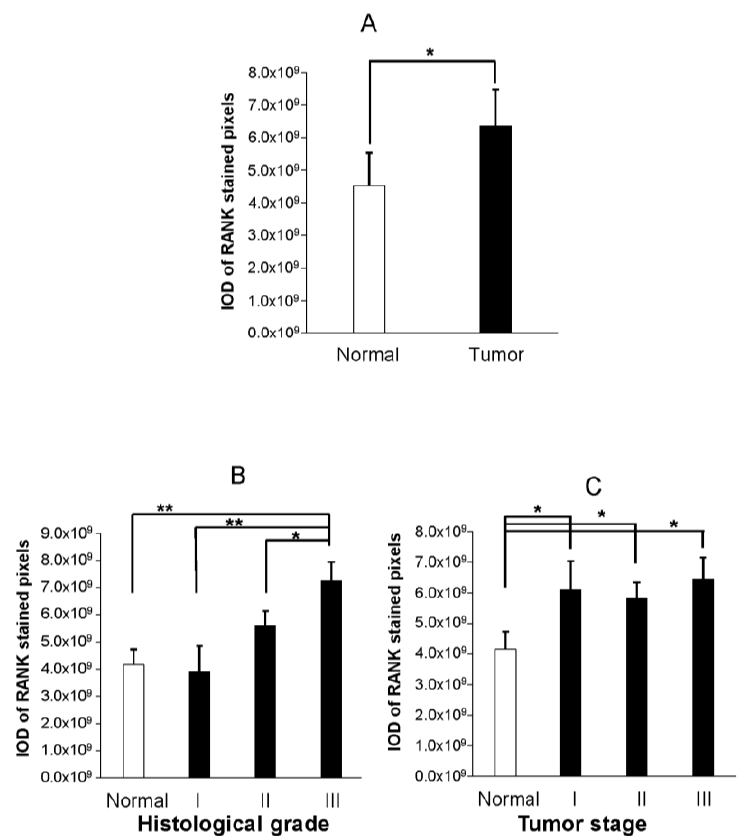
Figure 2. Graphs show mean ± SEM RANK protein expression as detected by quantitative immunohistochemistry in endometrium from normal and endometrial cancer samples. A Student’s t -test was employed for comparisons of RANK IHC staining between normal and tumor endometrial samples ( A ). An ANOVA followed by LSD post hoc analysis was performed to detect mean differences between normal and tumor samples grouped according to their histological grade ( B ) or tumor stage ( C ). Asterisks in ( B ) denote significant differences between histological grade III and the remaining (lower histological grade and normal endometrium samples) groups. Higher but not statistically significant RANK values were noted in histological grade II when compared to histological grade I or to normal samples ( p = 0.105, p = 0.094, respectively). Asterisks in ( C ) denote statistically significant differences between normal and each of the groups resulting from grouping pathological samples according to their tumor stage. No differences in IHC staining values were detected when tumor stages groups were compared to each other. * p < 0.05, ** p < 0.01.